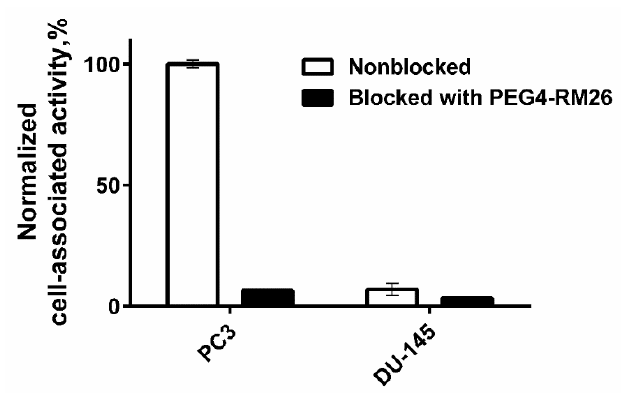
Figure 3. In vitro specificity of [ 125 I]I-Tyr-PEG 2 -RM26 to PC-3 and DU-145 cells. Radiolabelled conjugate was added to cultured cells at a concentration of 1 nM. One set of culture dishes was pre-saturated with a 200-fold molar excess of non-labelled NOTA-PEG 4 -RM26 before incubation with the labelled conjugate.